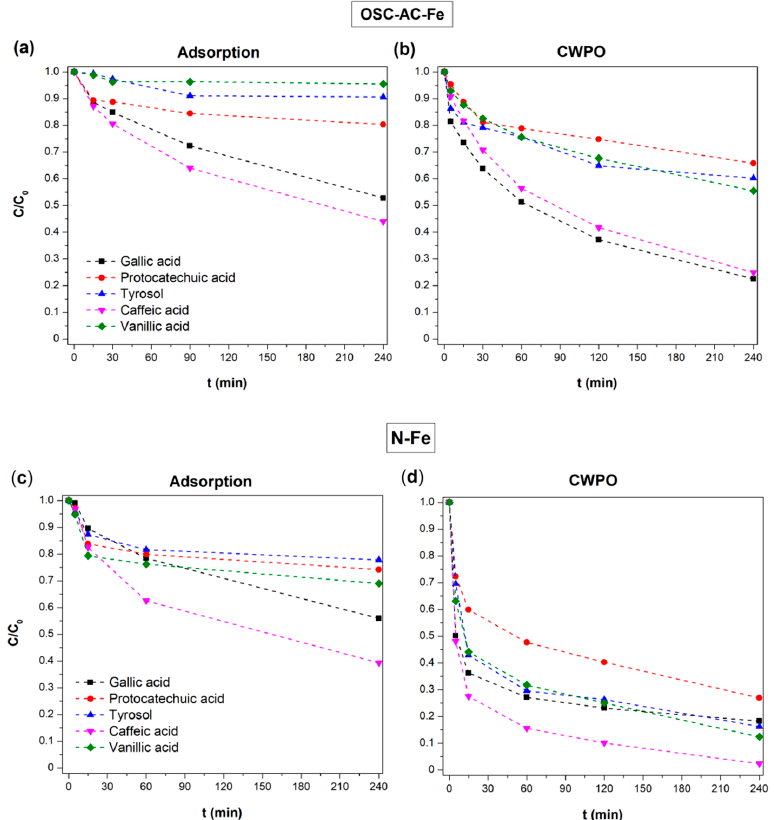
Figure 11. Comparison of phenolic compounds’ removal by adsorption or CWPO using OSC-AC-Fe and N-Fe catalysts.